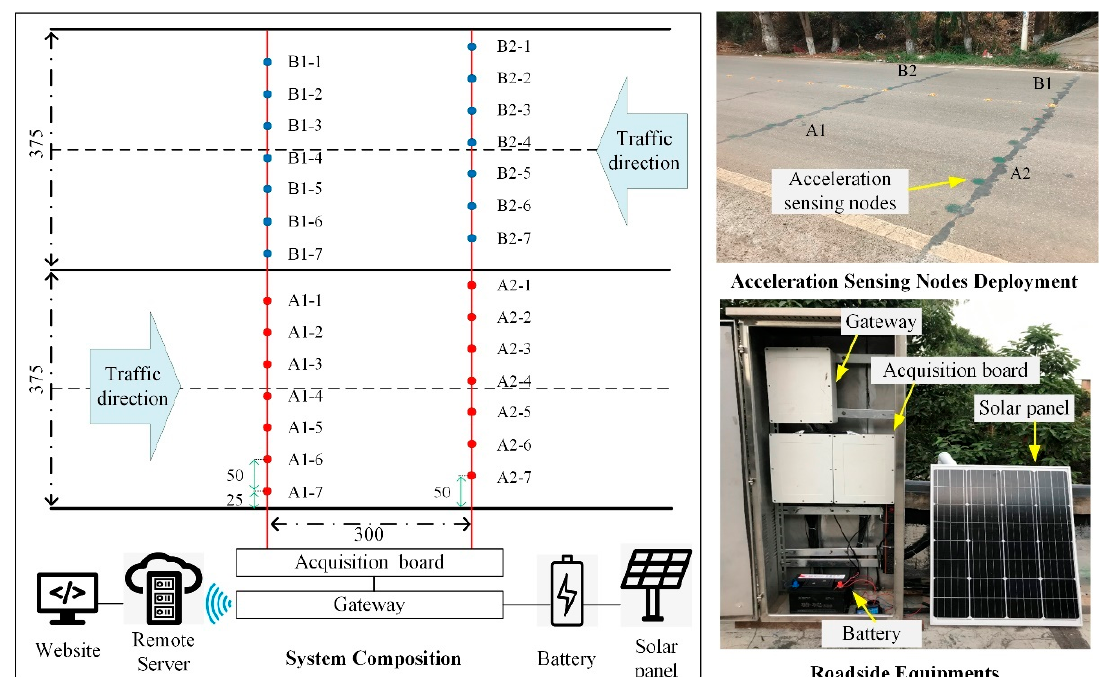
Figure 1. Pavement vibration IoT monitoring system.